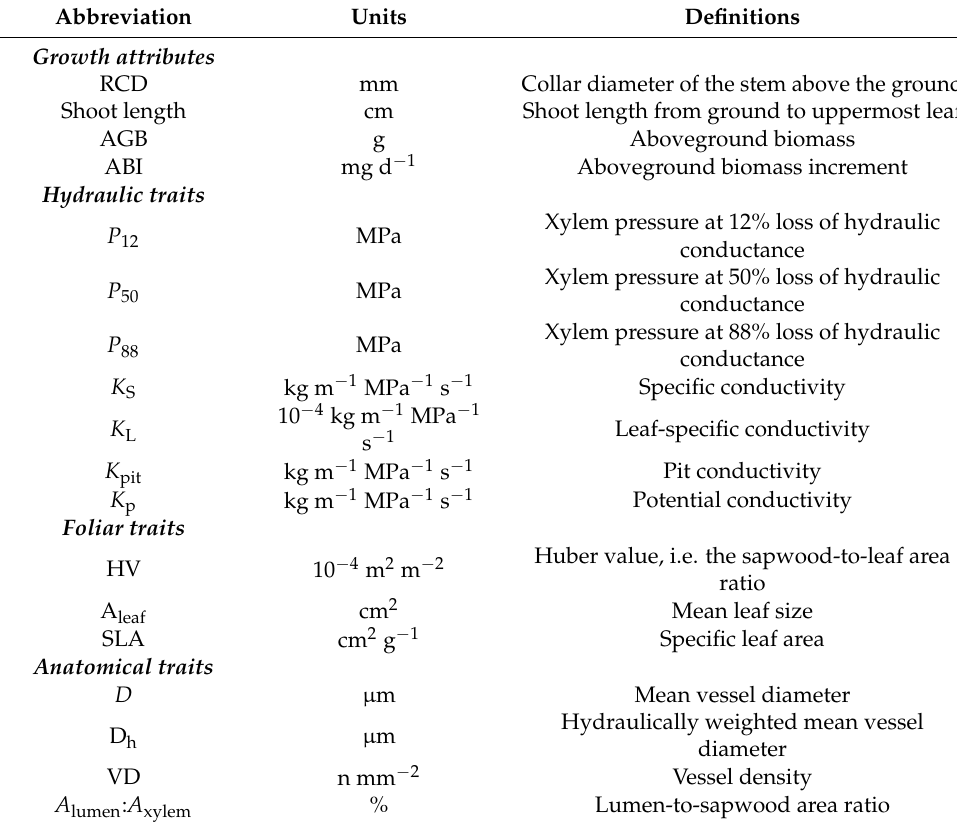
Table 1. List of variables included in this study with their definitions and